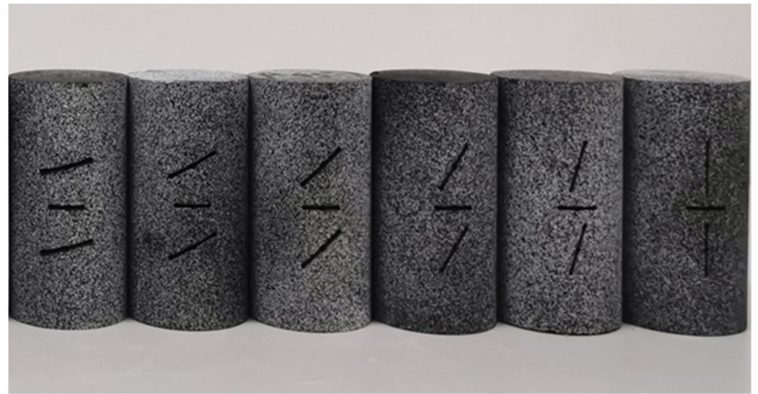
Figure 4. Limestone specimens sprayed with